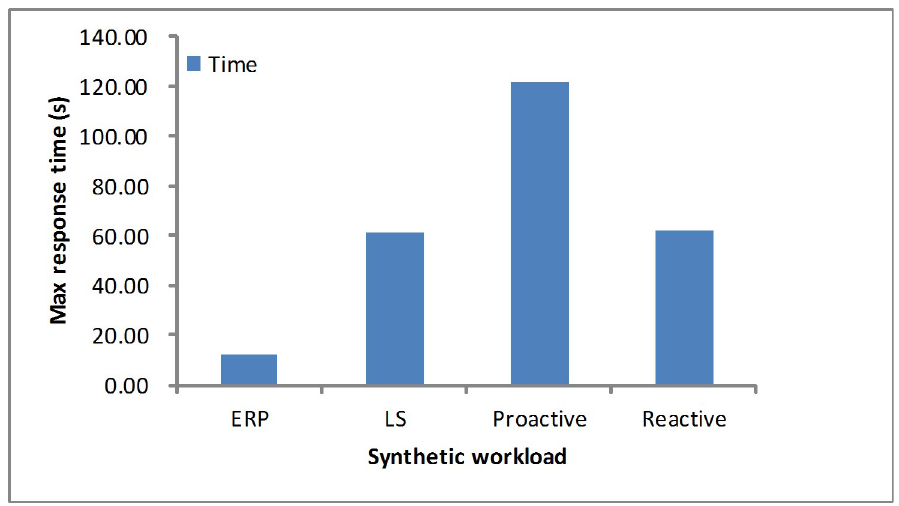
Fig 12. Max response time in the synthetic